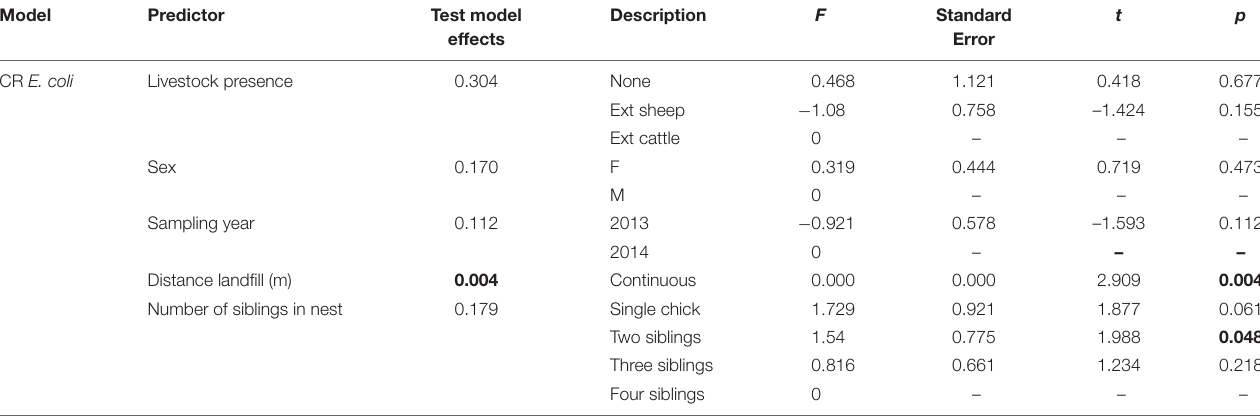
TABLE 3 | Results of generalized mixed linear model (GLMM) for cephalosporin resistant (CR) E. coli carriage in white stork nestlings in Spain.